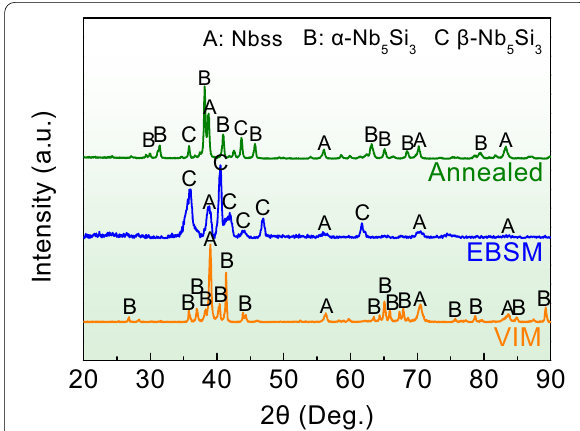
Figure 1 XRD patterns of the hypereutectic Nb-Si based alloys processed by VIM and EBSM